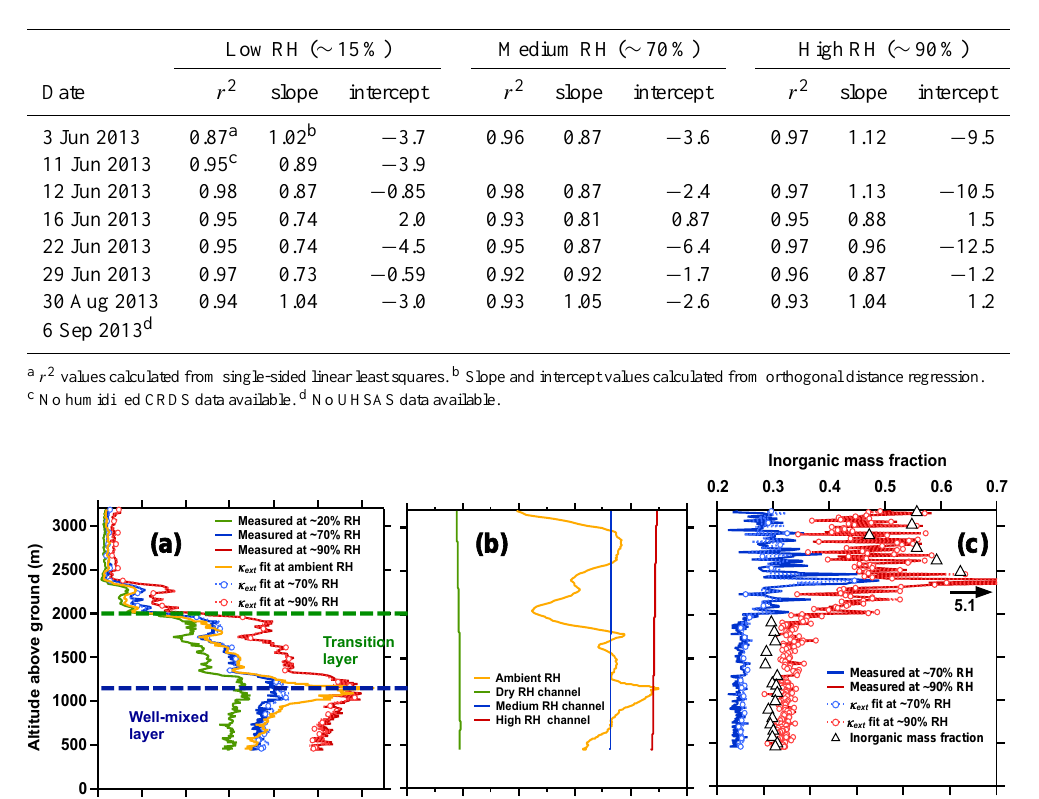
Table 2. Linear regression parameters between calculated extinction and measured extinction at 532nm and three relative humidities for each flight analyzed in this work.